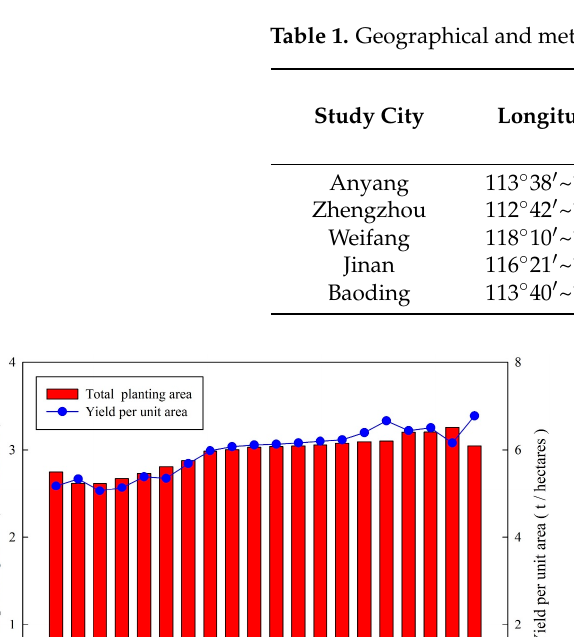
Table 1. Geographical and meteorological information of the five studied cities.